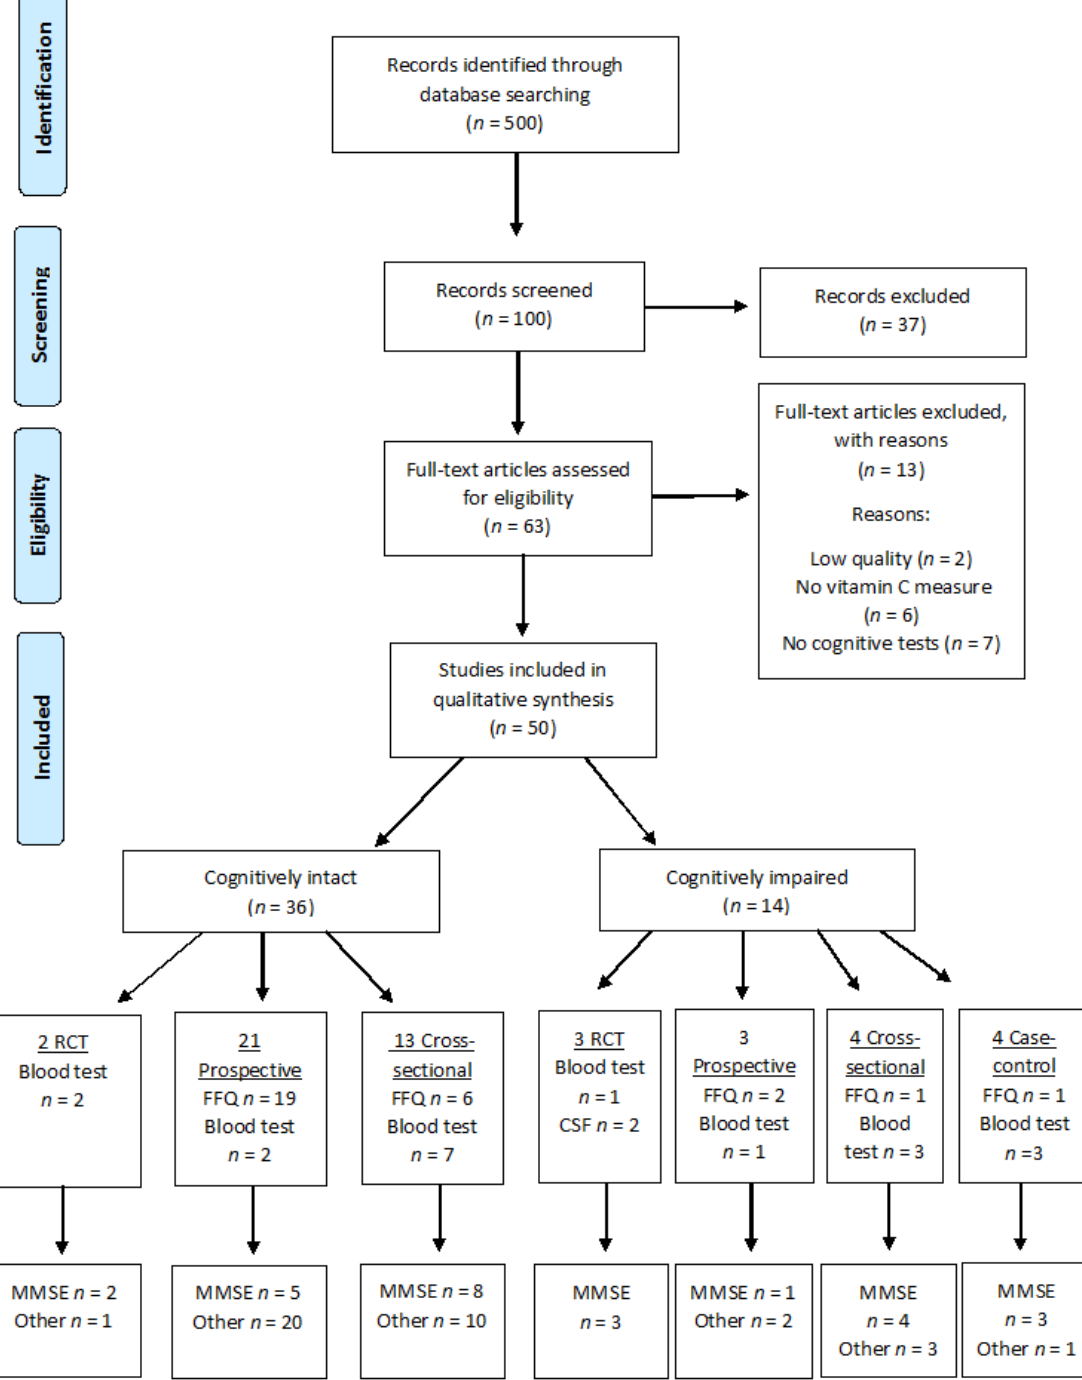
Figure 1. Flow chart of steps in systematic review.